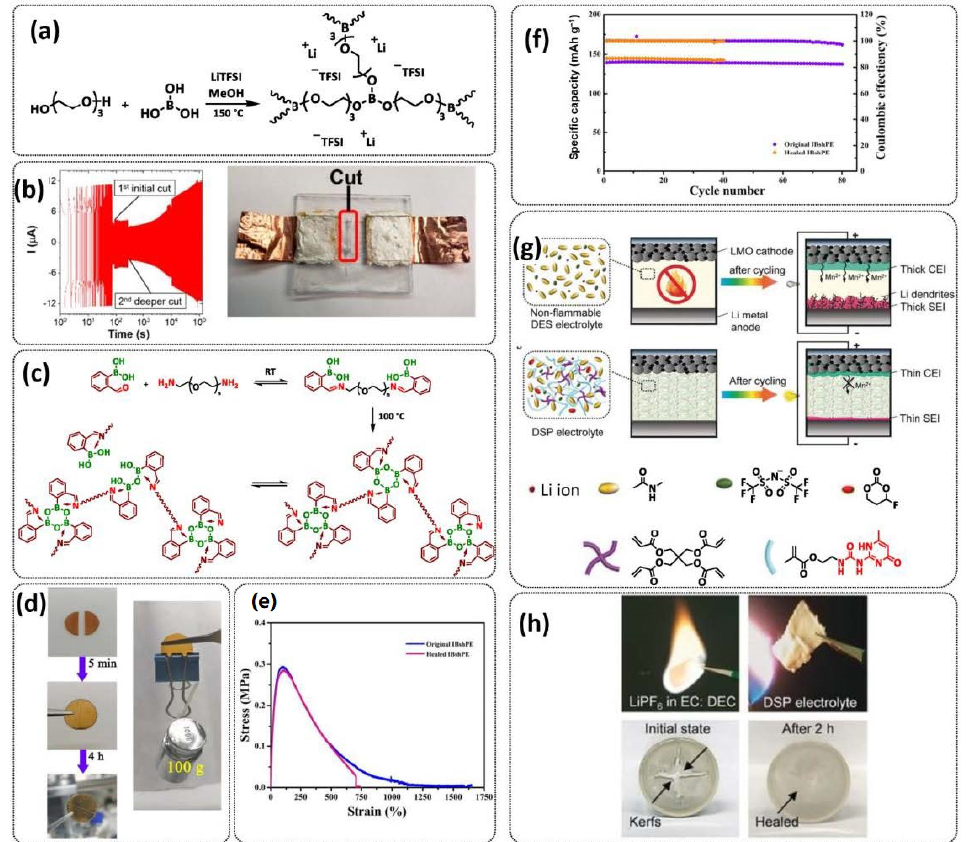
Figure 8. ( a ) Synthesis of dynamic network electrolytes from triethylene glycol and boric acid. ( b ) Current passed at ± 60 °C before and after the network was cut with a razor blade. After 34 h, 98% of the initial current was recovered. Reproduced with permission from [88]. Copyright © 2019, American Chemical Society. ( c ) Synthesis route of IBshPE and self-healing mechanism of a synergetic dynamic imine bond and boroxine bond. ( d ) Self-healing process of IBshPE in the glovebox at RT. ( e ) Stress – strain curves of original IBshPE and healed IBshPE. ( f ) Cycle performance of LFP/original IBshPE/Li cell and of LFP/healed IBshPE/Li cell at a 1C rate. Reproduced with permission from [87]. Copyright © 2022, Elsevier B.V. All rights reserved. ( g ) Deep eutectic solvent (DES) and DES-based self-healing polymer (DSP) electrolytes in Li||LMO cells. ( h ) Optical images of the 1m LiPF 6 in EC/DEC electrolyte (top left) and DSP electrolyte (top right) under a combustion test and the self- healing process of the DSP electrolyte after being cut (bottom). Reproduced with permission from